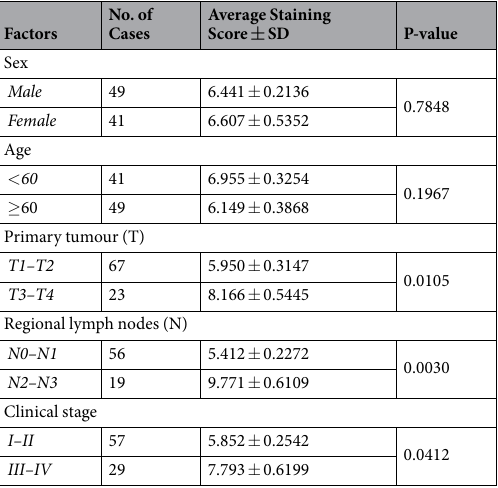
Table 1. Association of SLC39A4 expression and clinicopathological findings in NSCLC. Clinical and TNM staging were scored according to the American Joint Committee on Cancer: AJCC Cancer Staging Manual, 7th edition.